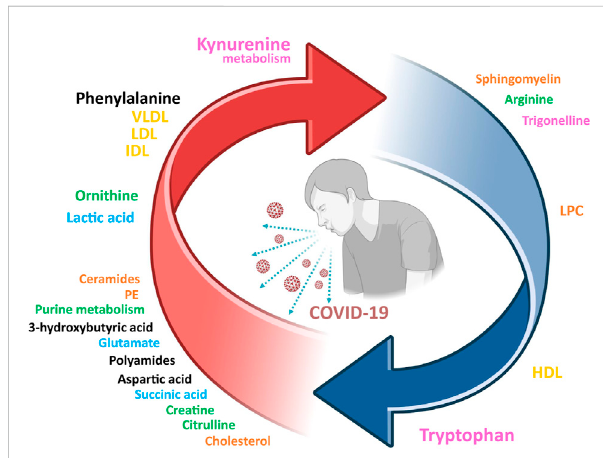
FIGURE 1 A consensus view of the metabolic signature of COVID-19 patients. Arrow colors indicate if metabolites are upregulated (red) or downregulated (blue). The letter size is proportional to the supporting experimental evidence. Color legend for the metabolic pathways: tryptophan metabolism (pink), central metabolism (blue), purine metabolism and urea cycle (green), lipids (orange), lipoproteins (yellow), other (black). VLDL, very low-density lipoproteins; LDL, low density lipoproteins; HDL, high density lipoproteins; IDL, intermediate density lipoproteins; PE,